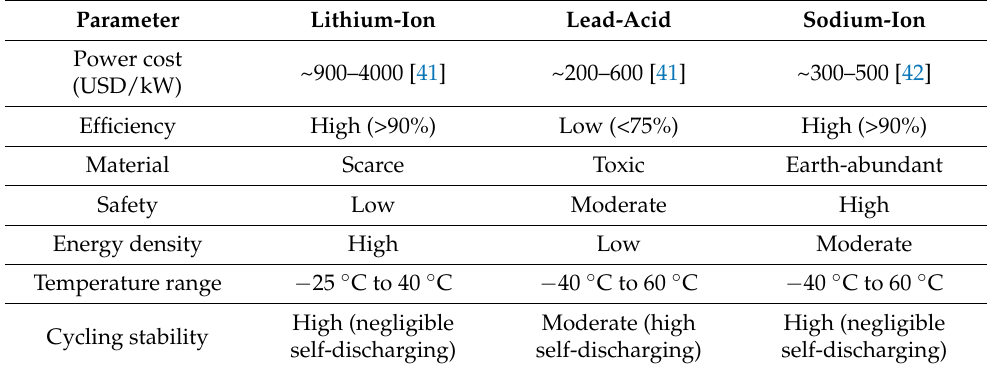
Table 5. Comparison between